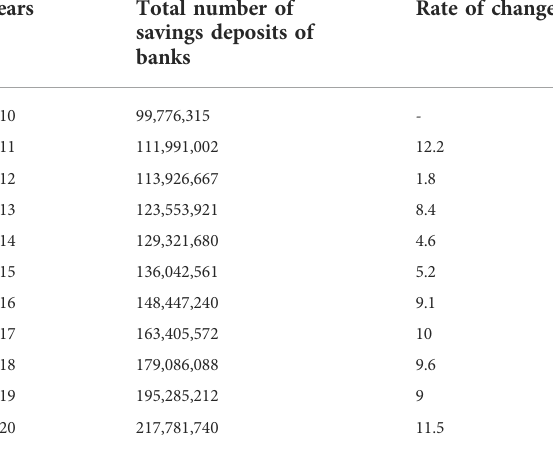
TABLE 7 Total number of savings deposits of banks during 2010 –